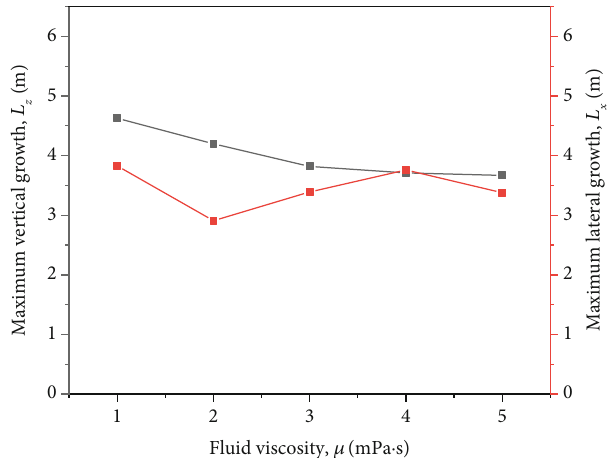
Figure 15: Variations of the maximum vertical and lateral growth for di ff erent fl uid